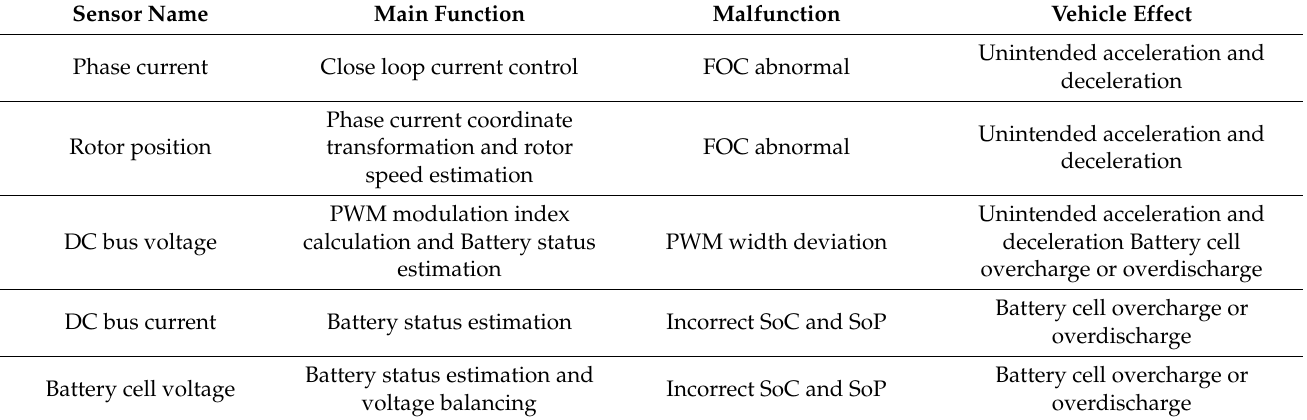
Table 1. Functional hazard